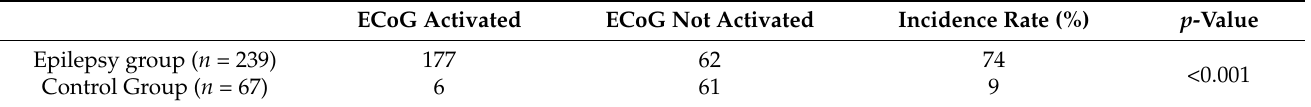
Table 2. The activation of ECoGs in the epilepsy group and control group. ECoG Activated ECoG Not Activated Incidence Rate (%) p -Value Epilepsy group ( n = 239) 177